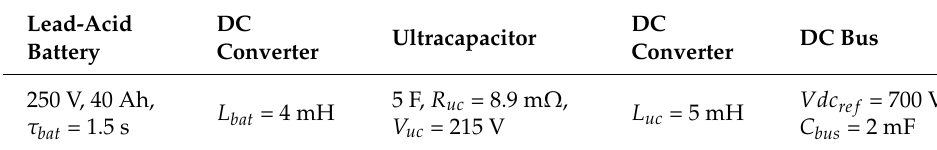
Table 4. DC system parameters.